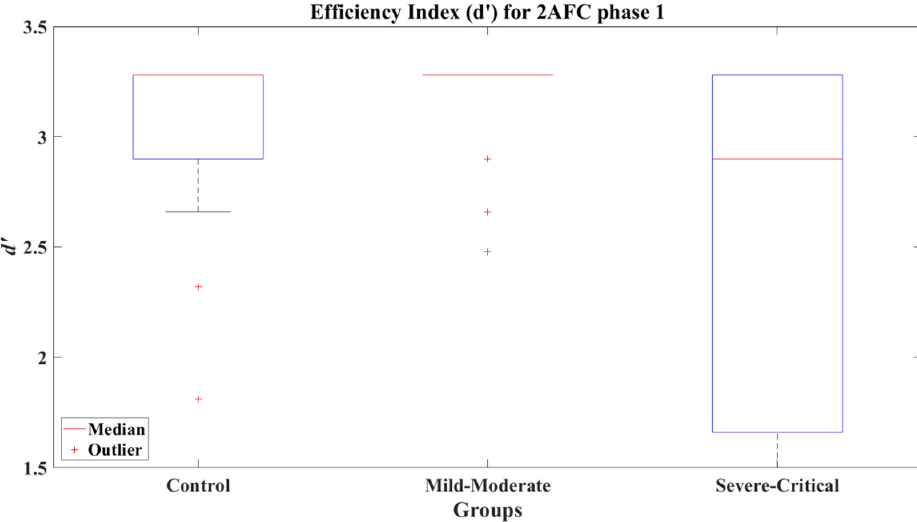
Figure 5. Efficiency index d’ for 2AFC phase 1 (2AFC-P1) by group.